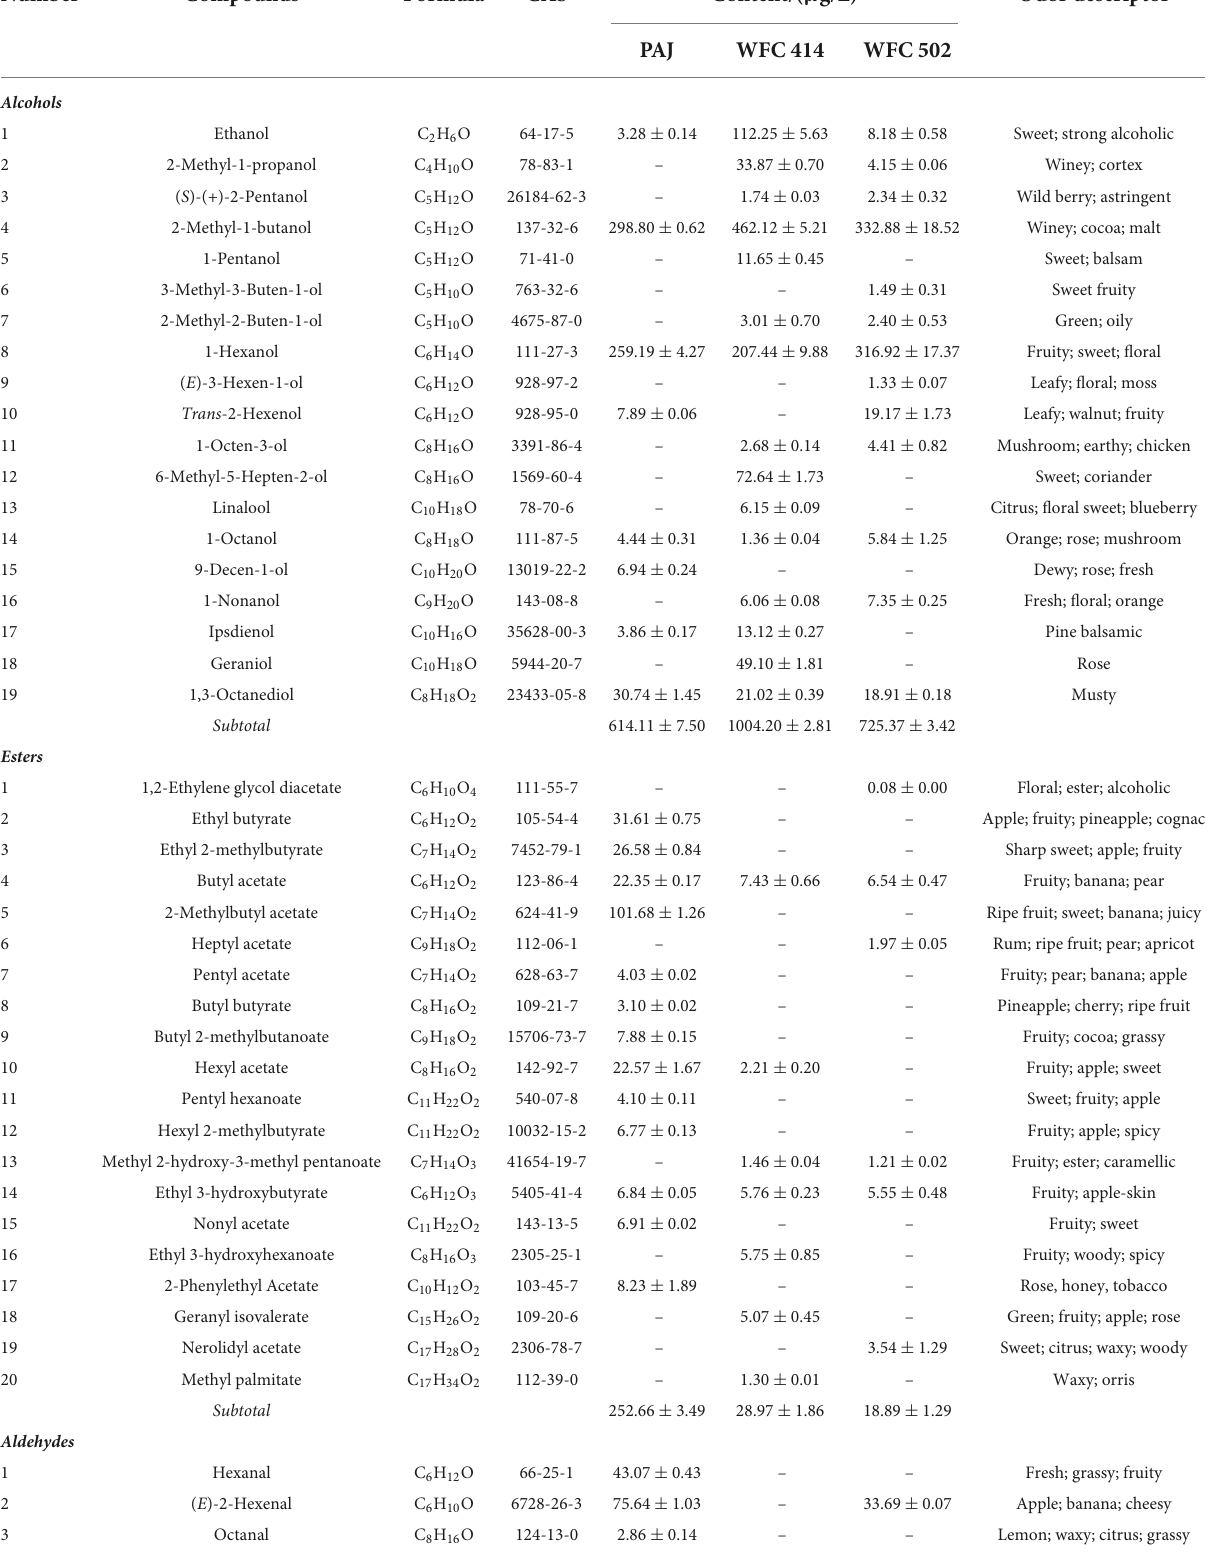
TABLE 5 The volatile compounds content in pasteurized apple juice (PAJ) and WFC 414 and WFC 502 fermented apple juice